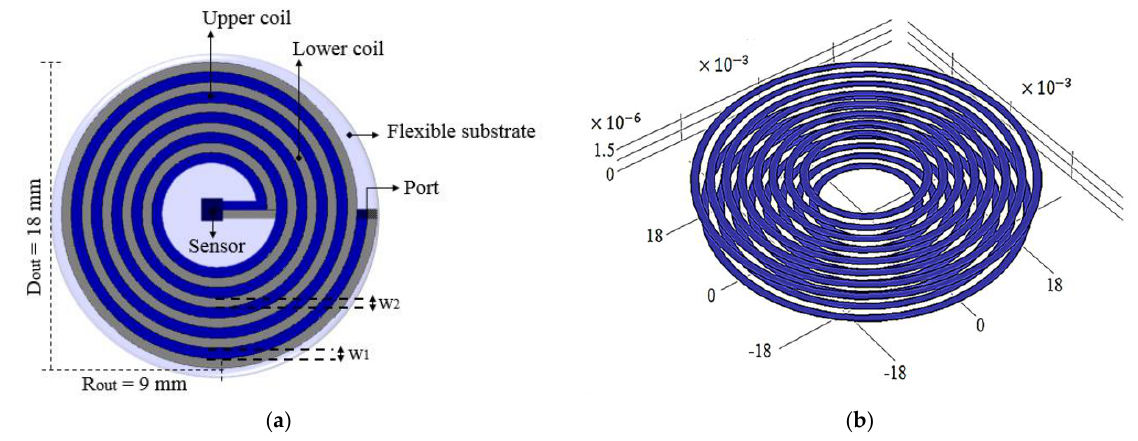
Figure 3. ( a ) Top view and ( b ) 3D view of the designed two-level inductor